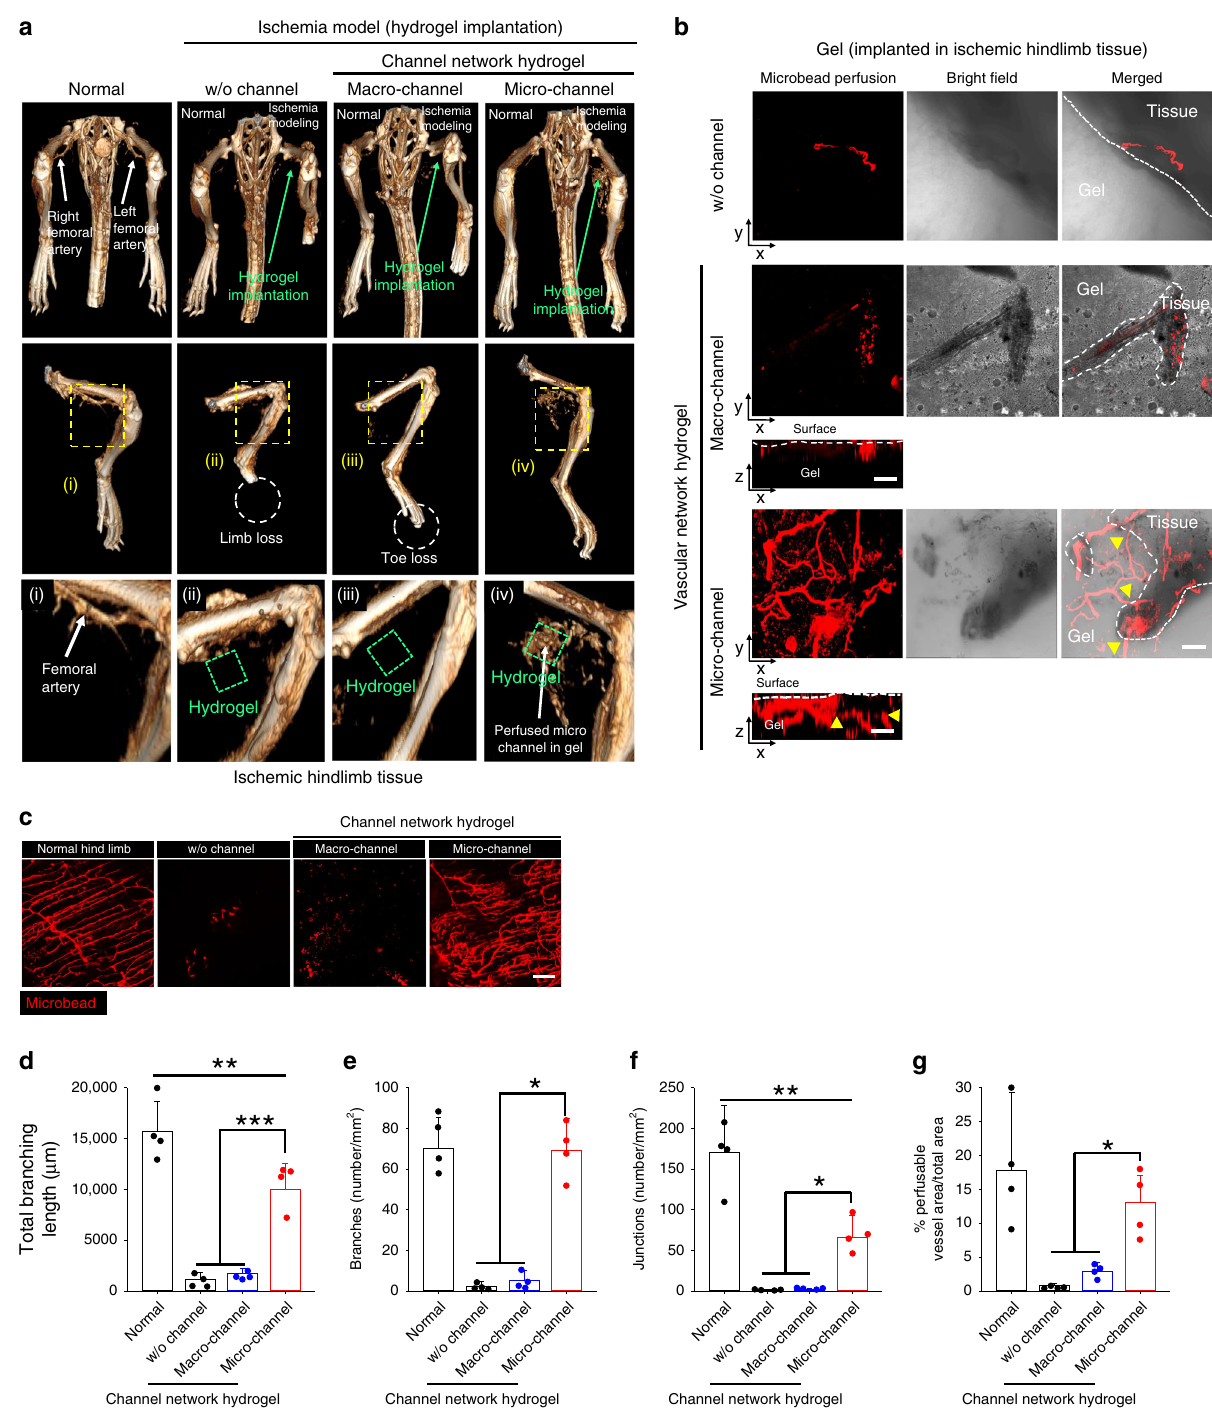
Fig. 2 Promotion of host vessel ingrowth and perfusion connection with channel networks. a MicroCT images of arterial vasculature in ischemic tissue of mouse hindlimb at day 14 post hydrogel implantation (green dot box). i – iv Middle and bottom rows: high magni fi cation images of the hydrogel implantation sites. Confocal images of harvested b whole channel network hydrogel and c hindlimb tissues post-perfusion of red FluoroSpheres, through the left ventricle at day 14 indicate ingrowth (yellow arrows) of host blood vessels and perfusion connection with the microchannel network (red). Scale bars = 100 μ m. Quanti fi cation of microvasculature structural parameters: d total branching length, e branch number, f junction number, and g perfusable vessel area per fi eld of view (FOV) at ischemic hindlimb tissue ( N = 4). Dots represent each animal. Data presented are mean ± SEM. Statistical signi fi cances are determined using one-way ANOVA with Tukey post-hoc pairwise comparisons; * p < 0.05, ** p < 0.01, and *** p < 0.005 between lined groups. Source data are provided as a Source Data fi